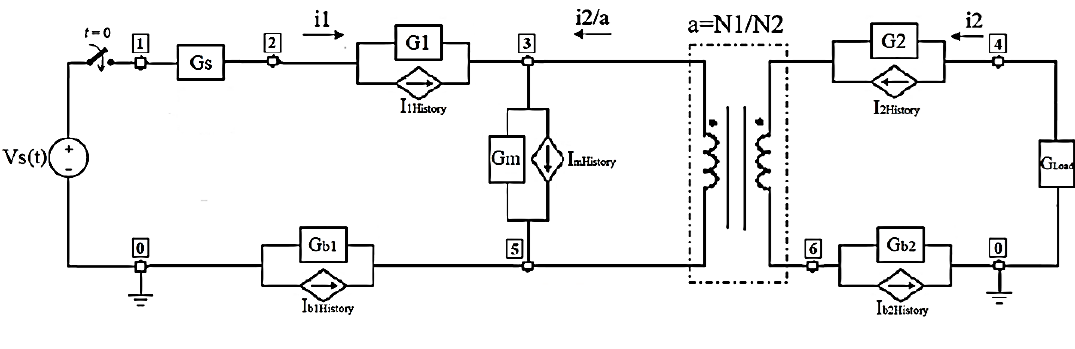
Figure 10. Test circuit to be analyzed by NIS-based network analysis algorithm.